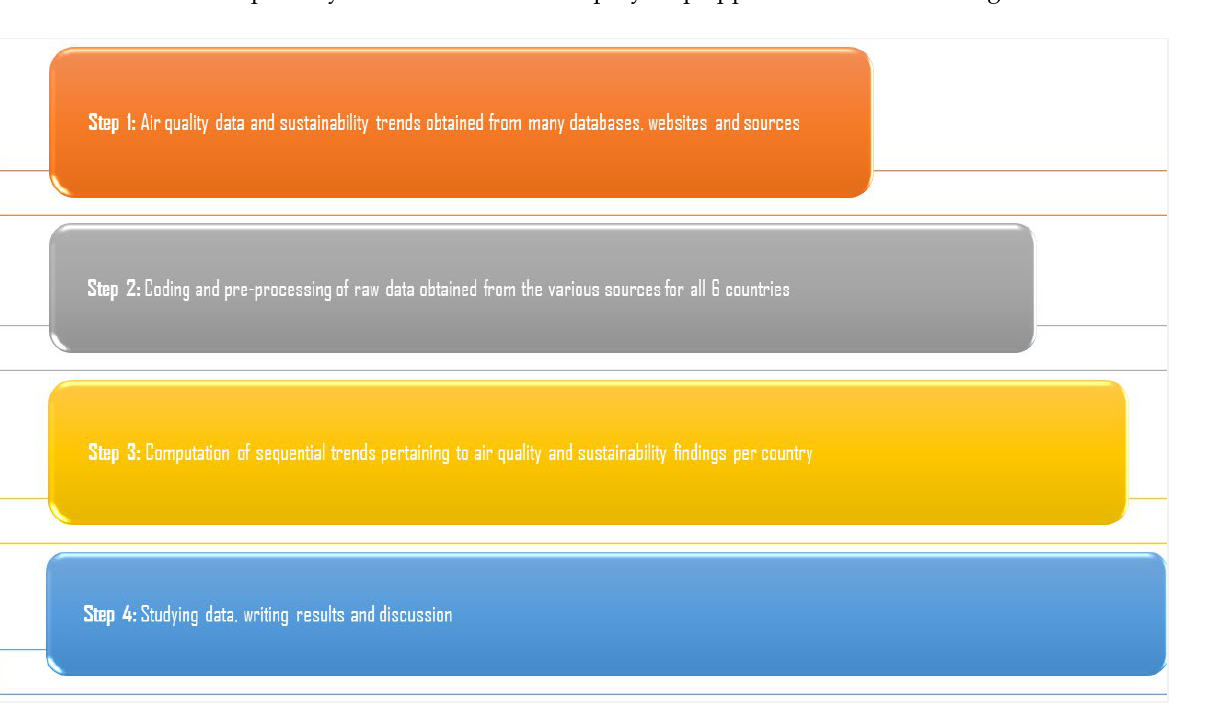
Figure 1. Step-wise breakdown of the employed methodology of epidemiological analysis.